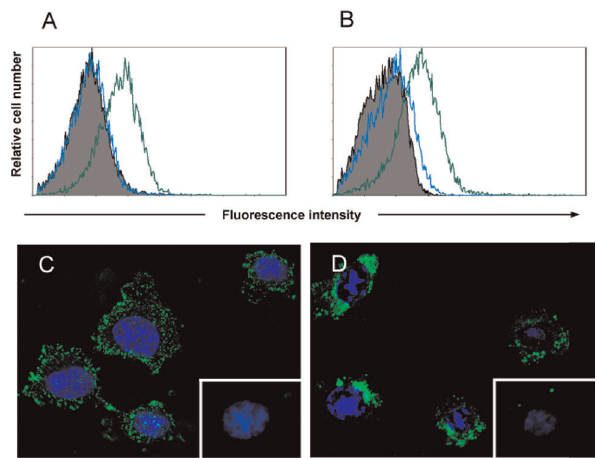
Figure 5. FACS profiles and representative microscopy images of HT1080 cells labeled with LM111 (A, C) or rLC111 (B, D), followed by incubation with rabbit anti-laminin antibody for the detection of LM111 (green line in FACS histogram A, and C) or anti-His mAb for the detection of rLC111 (green line in FACS histogram B, and D). To rule out the binding of anti-laminin antibody to endogenous laminin, HT1080 cells were incubated with the anti- laminin antibody in the absence of added LM111 (blue line in FACS histogram A, and inset C). A similar control was performed with the anti-His mAb in the absence of added rLC111 (blue line in FACS histogram B, and inset D).